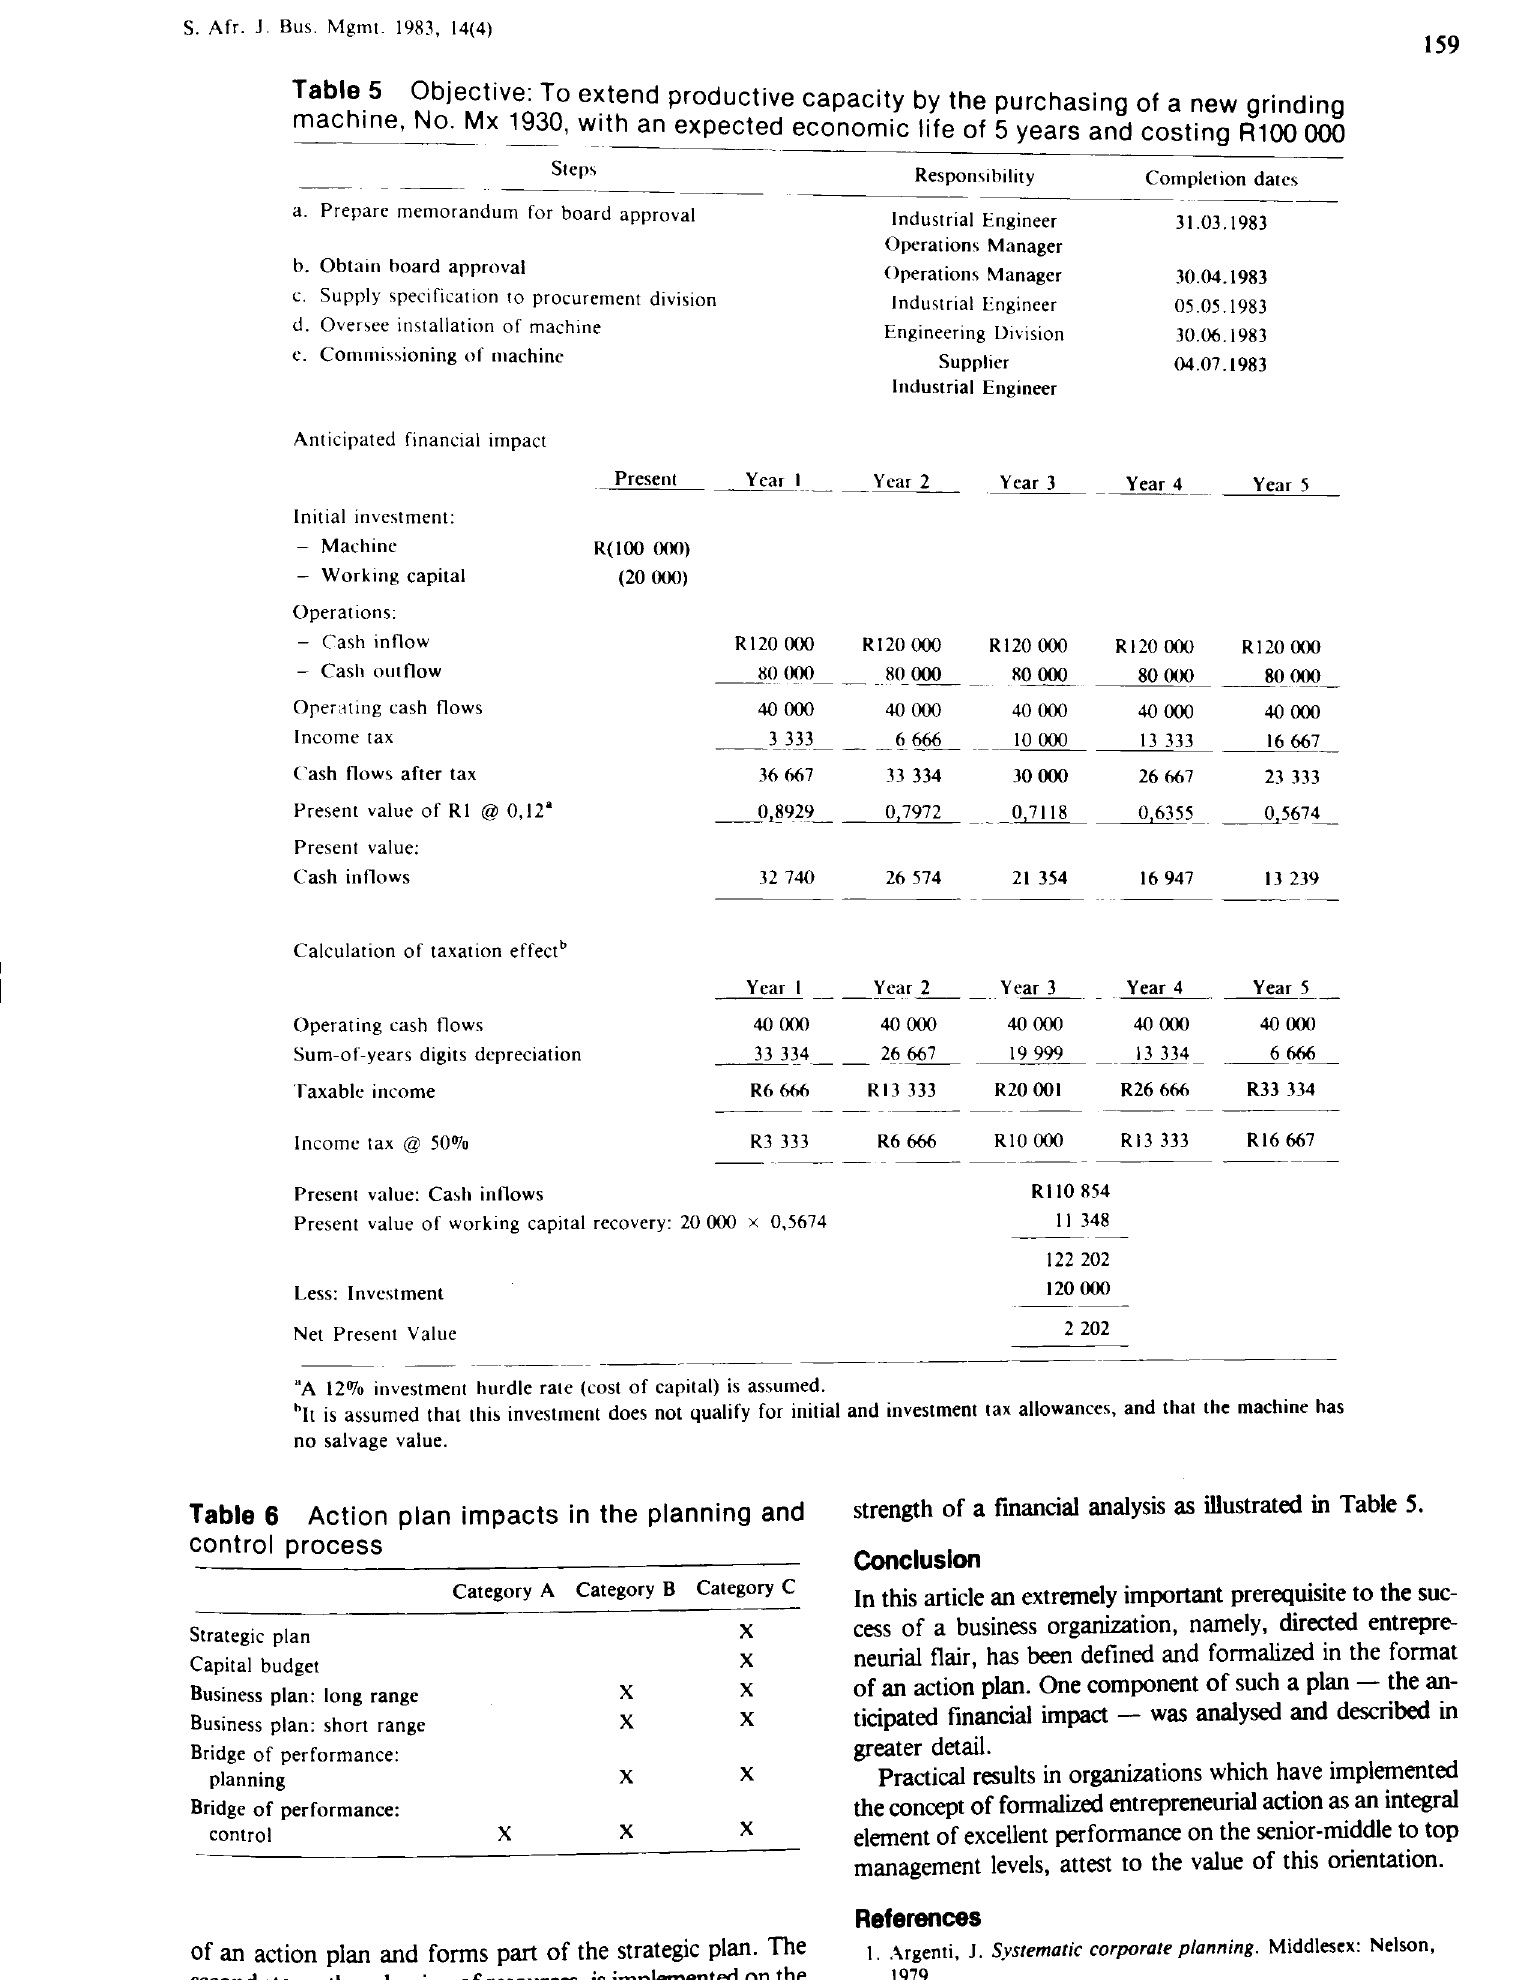
Objective: To e~tend productive capacity by the purchasing of a new rindin machine, No. Mx 1930, with an expected economic life of 5 years and costing ~100